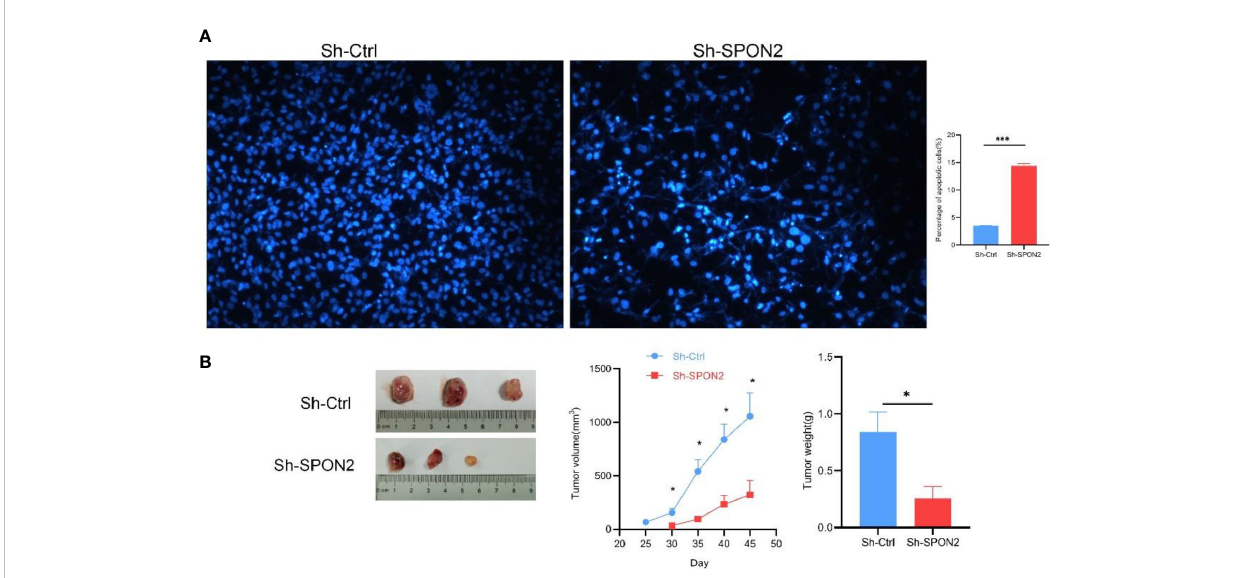
FIGURE 5 Knockdown of SPON2 promotes apoptosis of MDA-MB-231 cells and inhibits subcutaneous tumorigenesis in nude mice. (A) Hoechst apoptosis assay shows that knockdown of SPON2 increases apoptosis in MDA-MB-231 cells. Magni fi cation times: ×100. (B) Inhibition of subcutaneous